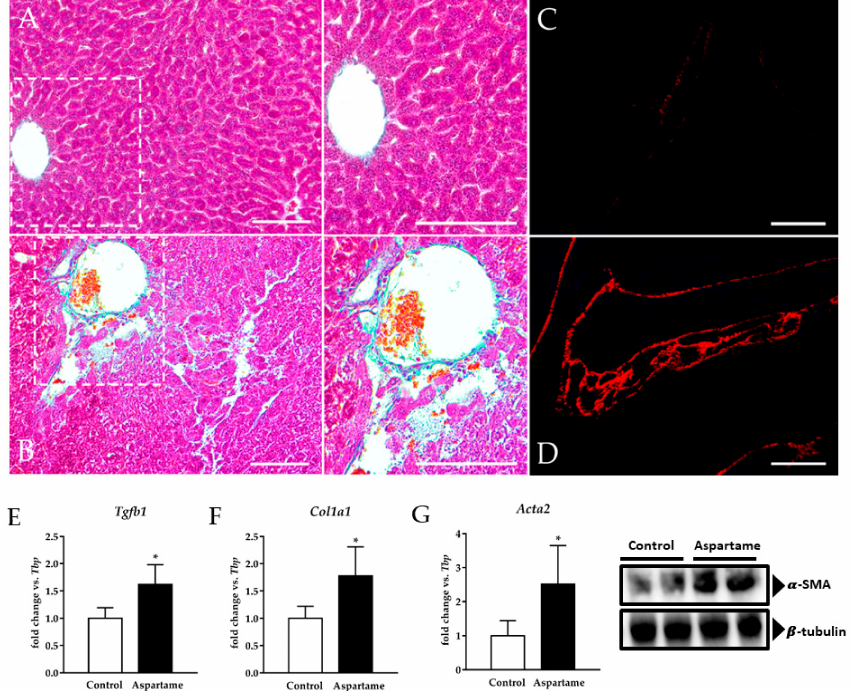
Figure 2. Representative images of Masson–Goldner’s trichrome and Sirius Red staining in the livers of control ( A and C , respectively) and aspartame-treated mice ( B and D , respectively) ( n = 4, each group). Scale bar = 100 µ m. mRNA relative expression of transforming growth factor β 1 ( Tgfb1 ) ( E ), collagen type I alpha 1 ( Col1a1 ) ( F ), and alpha smooth muscle actin ( Acta2 ) ( G ) versus Tbp measured by RT-qPCR in the livers of control and aspartame-treated mice ( n = 6, each group). Representative image of Western blotting of alpha smooth muscle actin ( α -SMA) in the livers of control and aspartame-treated mice ( n = 4, each group). β -tubulin was used as a loading control ( D ). The statistical difference is indicated as follows: * p < 0.05 versus